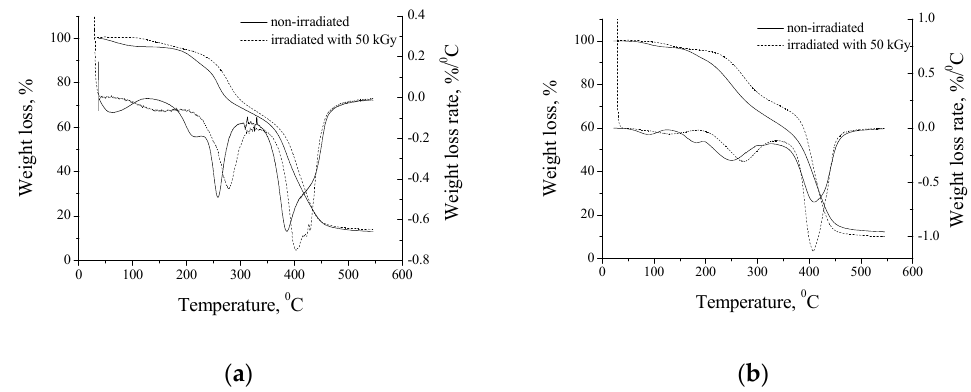
Figure 8. TG curves for ( a ) PAH18 and ( b ) PAH9 before and after irradiation.